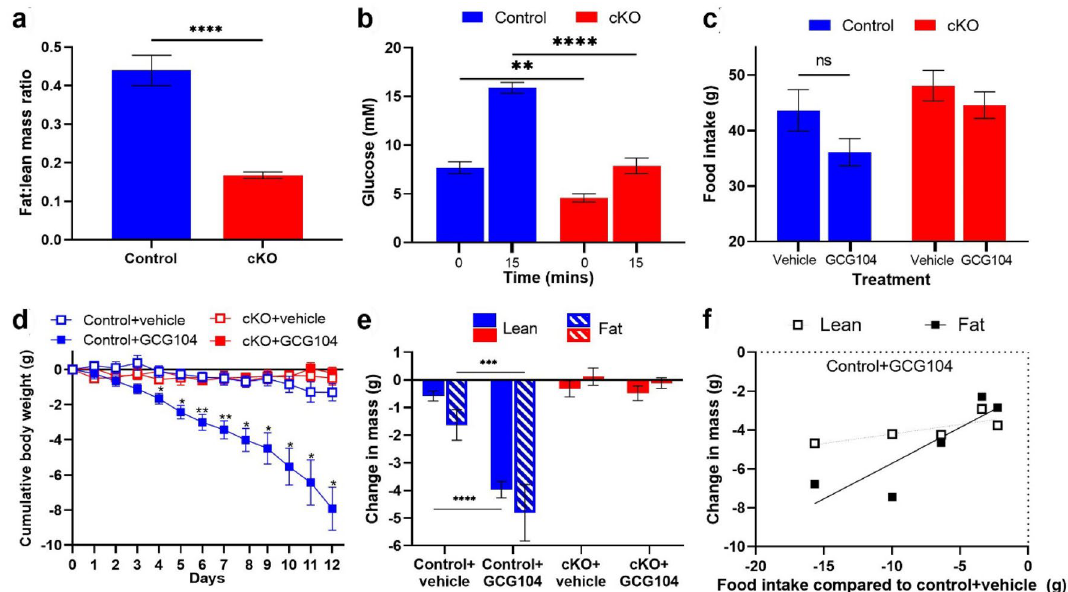
Figure 2. GCG104 reduces body weight in mice via the GCGR. ( a ) Fat:lean mass ratio of the cKO animals (n = 10) and controls (n = 11; unpaired t test). ( b ) Baseline and 15-min glucose response readings for an IPGTT (2 g/kg) in the cKO (n = 5) and control animals (n = 6; two-way ANOVA with Sidak post hoc test). ( c ) 12-day cumulative food intake for control and cKO animals injected daily with vehicle or 7.5 nmol/kg GCG104 (n = 5 per group; two-way ANOVA with Sidak post hoc test). ( d ) 12-day cumulative body weight change in control and cKO animals injected daily with vehicle or 7.5 nmol/kg GCG104. (n = 5 per group; repeated measures 2-way ANOVA with Tukey’s post hoc test). ( e ) 12-day change in body composition for control and cKO animals dosed with vehicle or 7.5 nmol/kg GCG104 (n = 5 per group; two-way ANOVA with Sidak post hoc test). ( f ) Correlation between change in body composition and reduction in food intake compared to vehicle-dosed control mice in GCG104-dosed control mice (Pearson’s r : fat = 0.87; lean = 0.79). p values indicated by ns p > 0.05, * p < 0.05, ** p < 0.01, *** p < 0.001 **** p < 0.0001. All data presented as mean ±